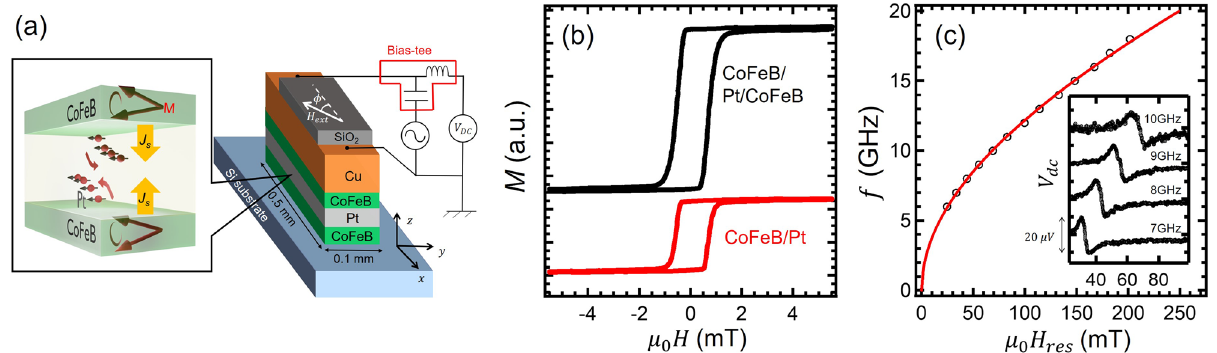
Figure 1. ( a ) Schematic illustration of the fabricated device based on CoFeB/Pt/CoFeB trilayer together with the probe configuration for RF measurements. The inset shows a conceptual image of the dynamical spin injection in the trilayer. ( b ) Room temperature M-H curves measured by VSM for CoFeB/Pt bilayer and CoFeB/ Pt/CoFeB trilayer. ( c ) Relationship between the resonant magnetic field H res and the microwave frequency f . The solid line represents the fitting curve using Kittel’s equation. The inset shows the field dependence of dc voltage under the microwave signal with various frequencies observed in the trilayered